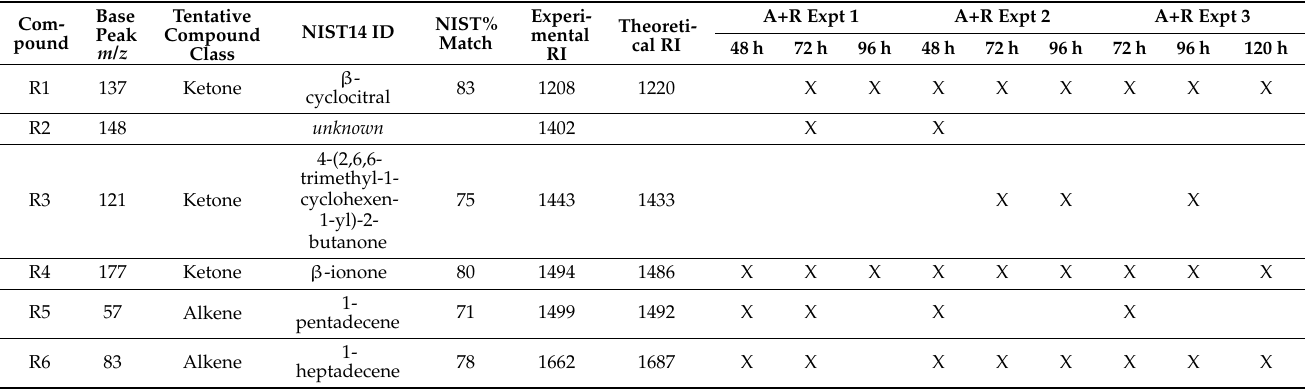
Table 1. Putative biomarkers emitted during grazing of Microchloropsis gaditana by Brachionus plicatilis and not present in time-matched healthy M. gaditana